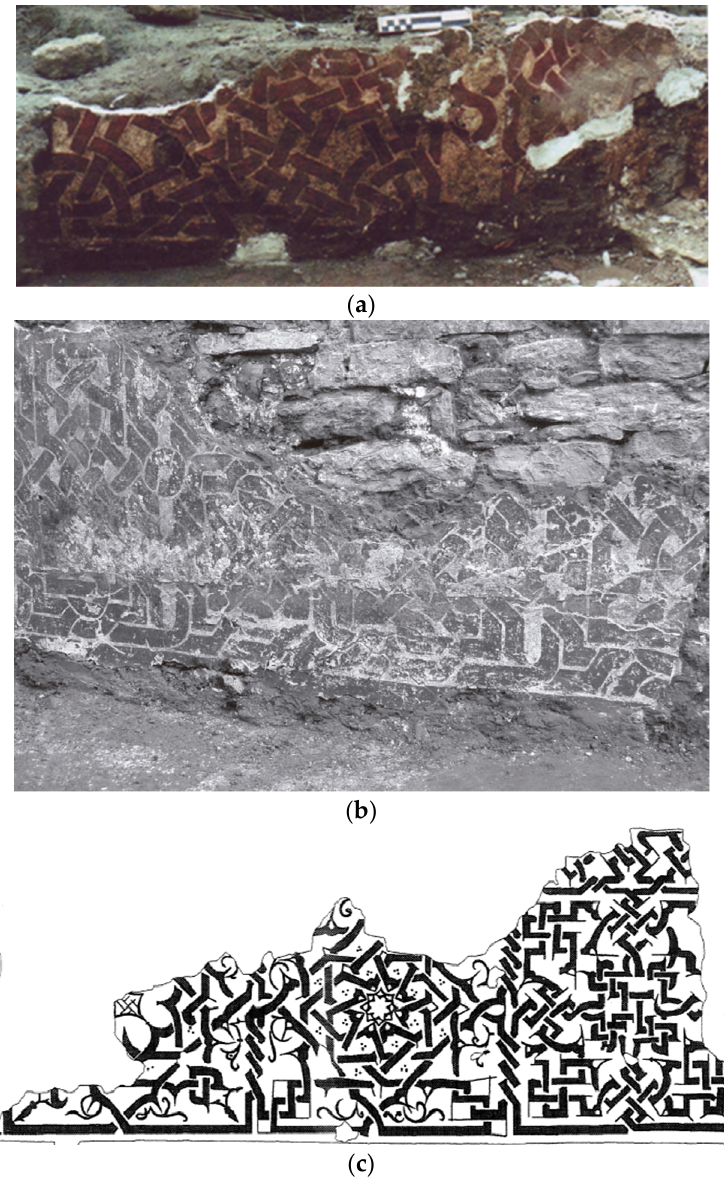
Figure 11. Style of “white backgrounds”, about the last third of the 12th century: ( a ) Palacio de Orive, Córdoba (Murillo et al. 1992); ( b ) Algeciras (López and Gestoso 2009, p. 234); ( c ) Cathedral of Sevilla (Jiménez 1999, p. 385).